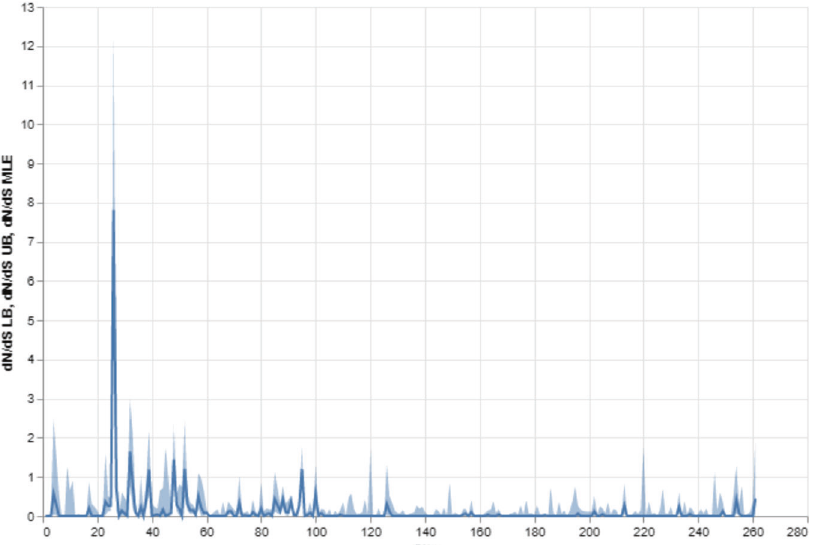
Fig. 1 Mammalian BDNF exhibits overwhelmingly strict purifying selection, but also evidence of speci fi c evolutionary pressures at particular sites. The FEL analysis of the BDNF gene found 174 of 261 (66.7%) sites to be statistically signi fi cant (LRT p value ≤ 0.1) for pervasive negative (purifying) selection. We plot the estimated values of omega (dN/dS) for each site in the alignment. Additionally, we plot 95% con fi dence intervals (CI) for each site. These results are also available in Table S1. We observe a high degree of strict purifying selection in the Human NGF region. The region for Human NGF corresponds to alignment sites 144 – 254 (NP_001700.2 and https://github.com/aglucaci/ AnalysisOfOrthologousCollections/blob/main/tables/BDNF/BDNF_AlignmentMap.csv). This alignment of BDNF across all selected species ( Mammalia , see Table 3) reveals a site-speci fi c positive/adaptive diversifying selection and negative purifying selection. The thick line represents the point estimate (i.e., the evolutionary pressure) and the shadings re fl ect 95% con fi dence intervals which relate to the upper and lower bound of the point estimates. As shown, the prodomain sites exhibit more pervasive/episodic and positive/diversifying evolutionary selection, consistent with the fact that more disease-associated SNPs occur in this topological region of the BDNF gene in humans (early prodomain mapping not further shown due to nuanced variation across mammalian